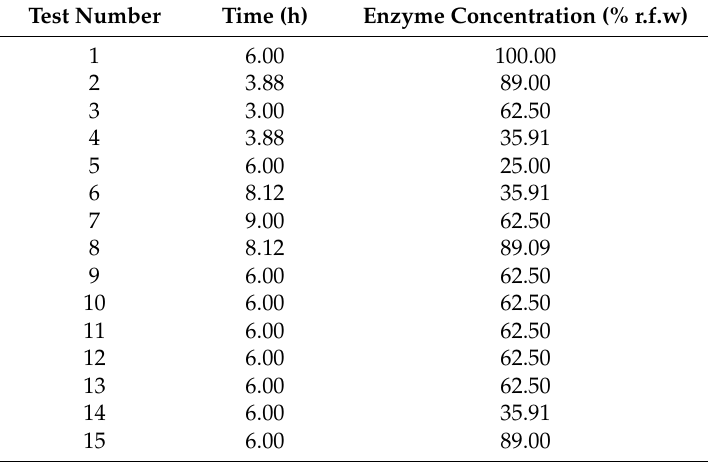
Table 3. Treatment conditions for Biopectinase K treatments in the last DoE. Test Number Time (h) Enzyme Concentration (%